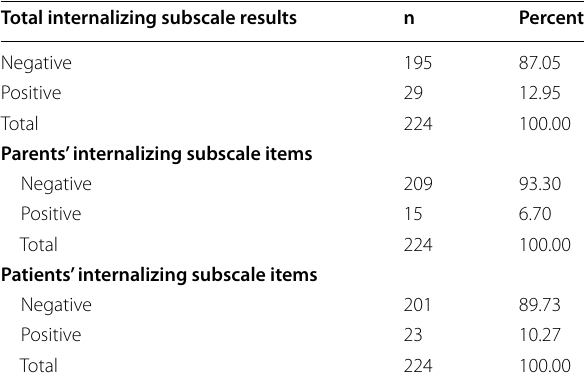
Table 1 Demographic data of the studied population Table 2 Results of Pediatric Symptom Checklist